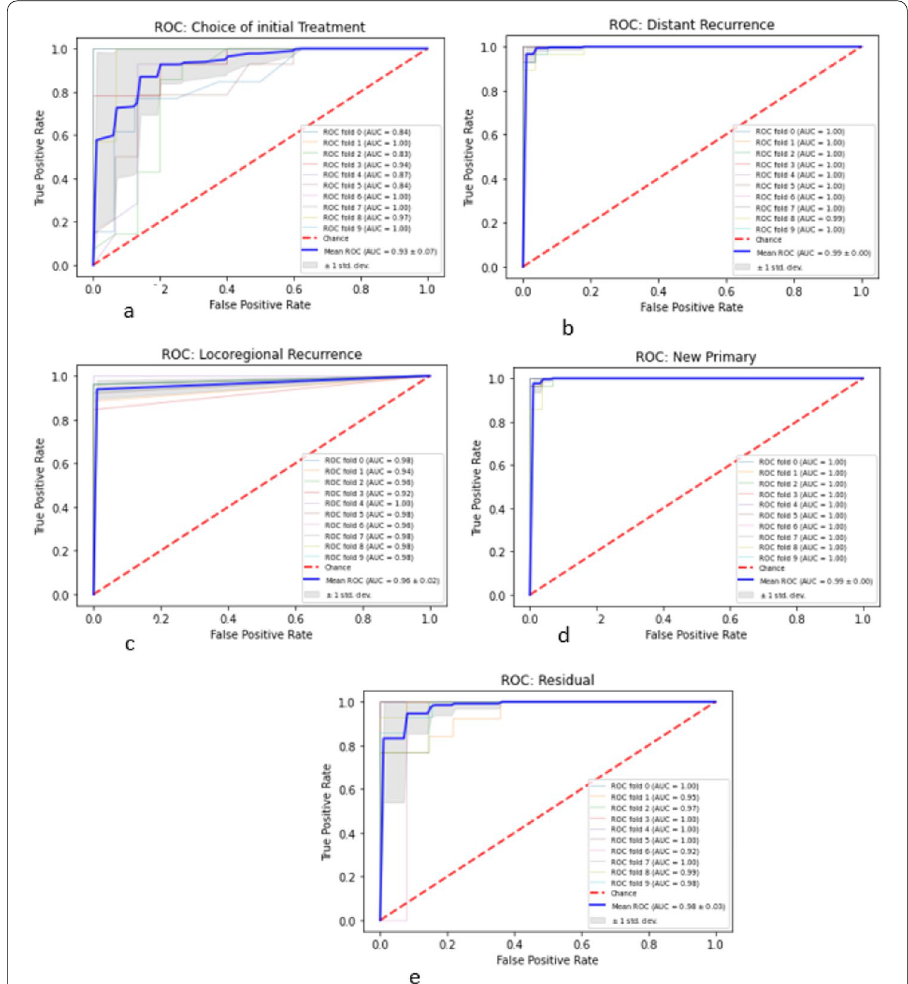
Fig. 3 Mean ROC plots for each model: a Choice of Initial Treatment, b Distant Recurrence, c Locoregional Recurrence, d New Primary, e